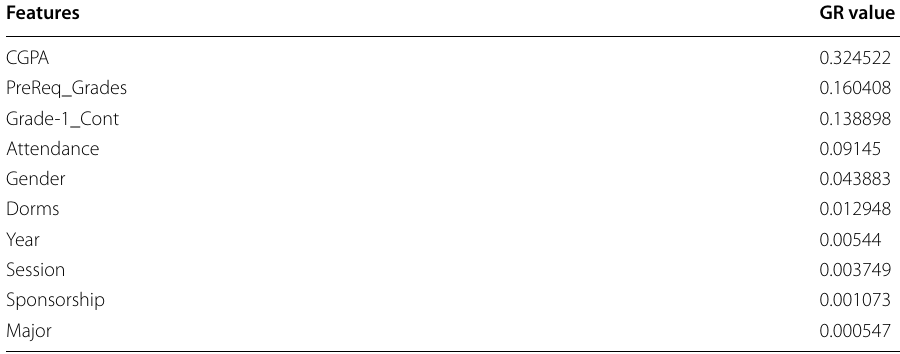
Table 3 Features in descending order with respect to their gain ratio values Features